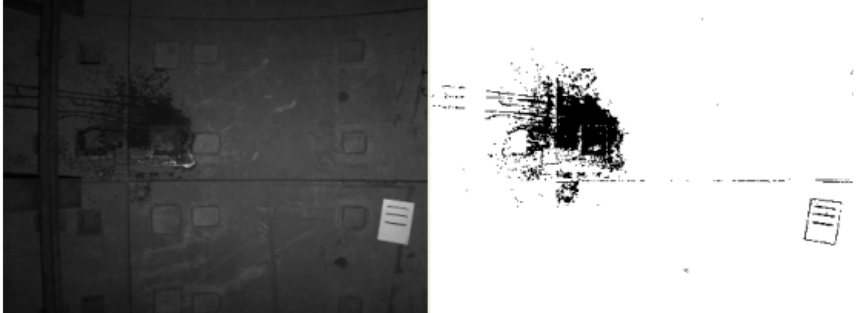
Figure 11. Extraction of man-made leakage in the metro